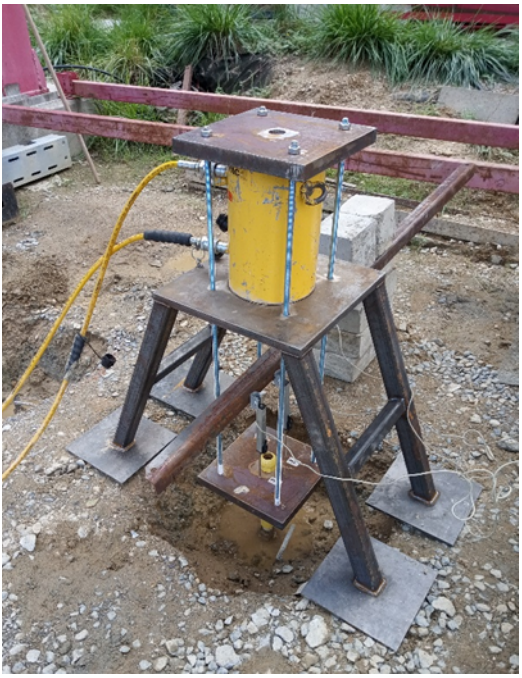
Figure 7. Installation of the traction rig at micropile traction load